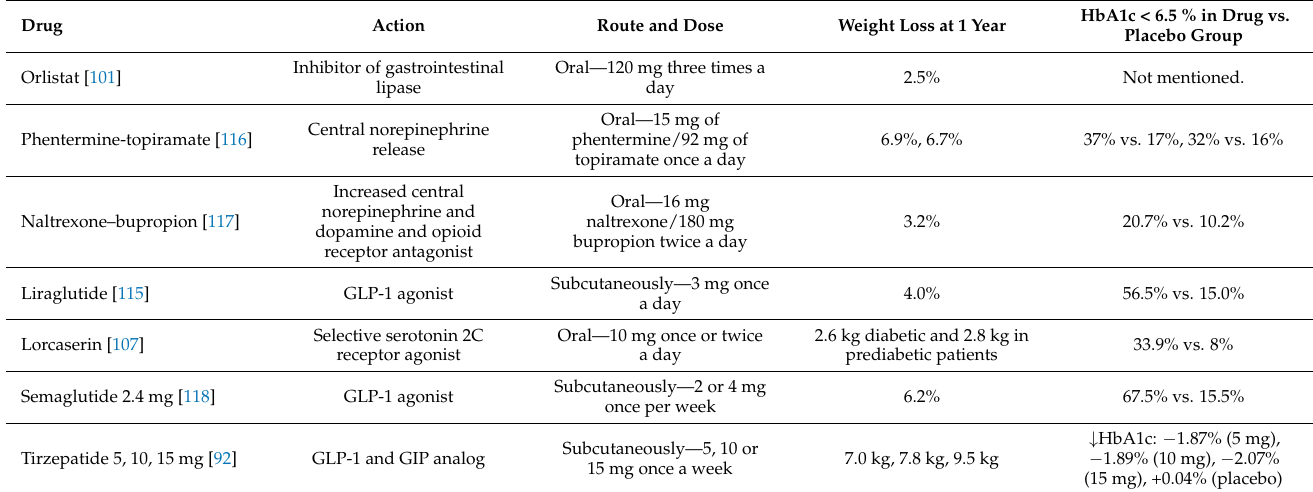
Table 4. Studies investigating the efficacy of antiobesity drugs in people with